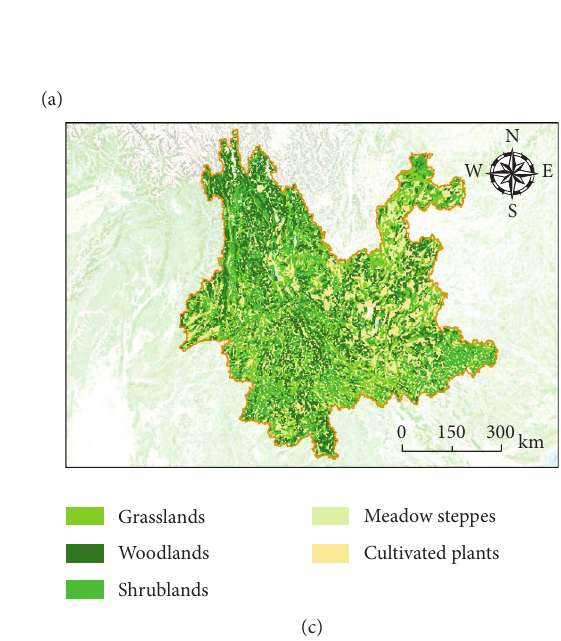
Figure 1: The study area across Yunnan